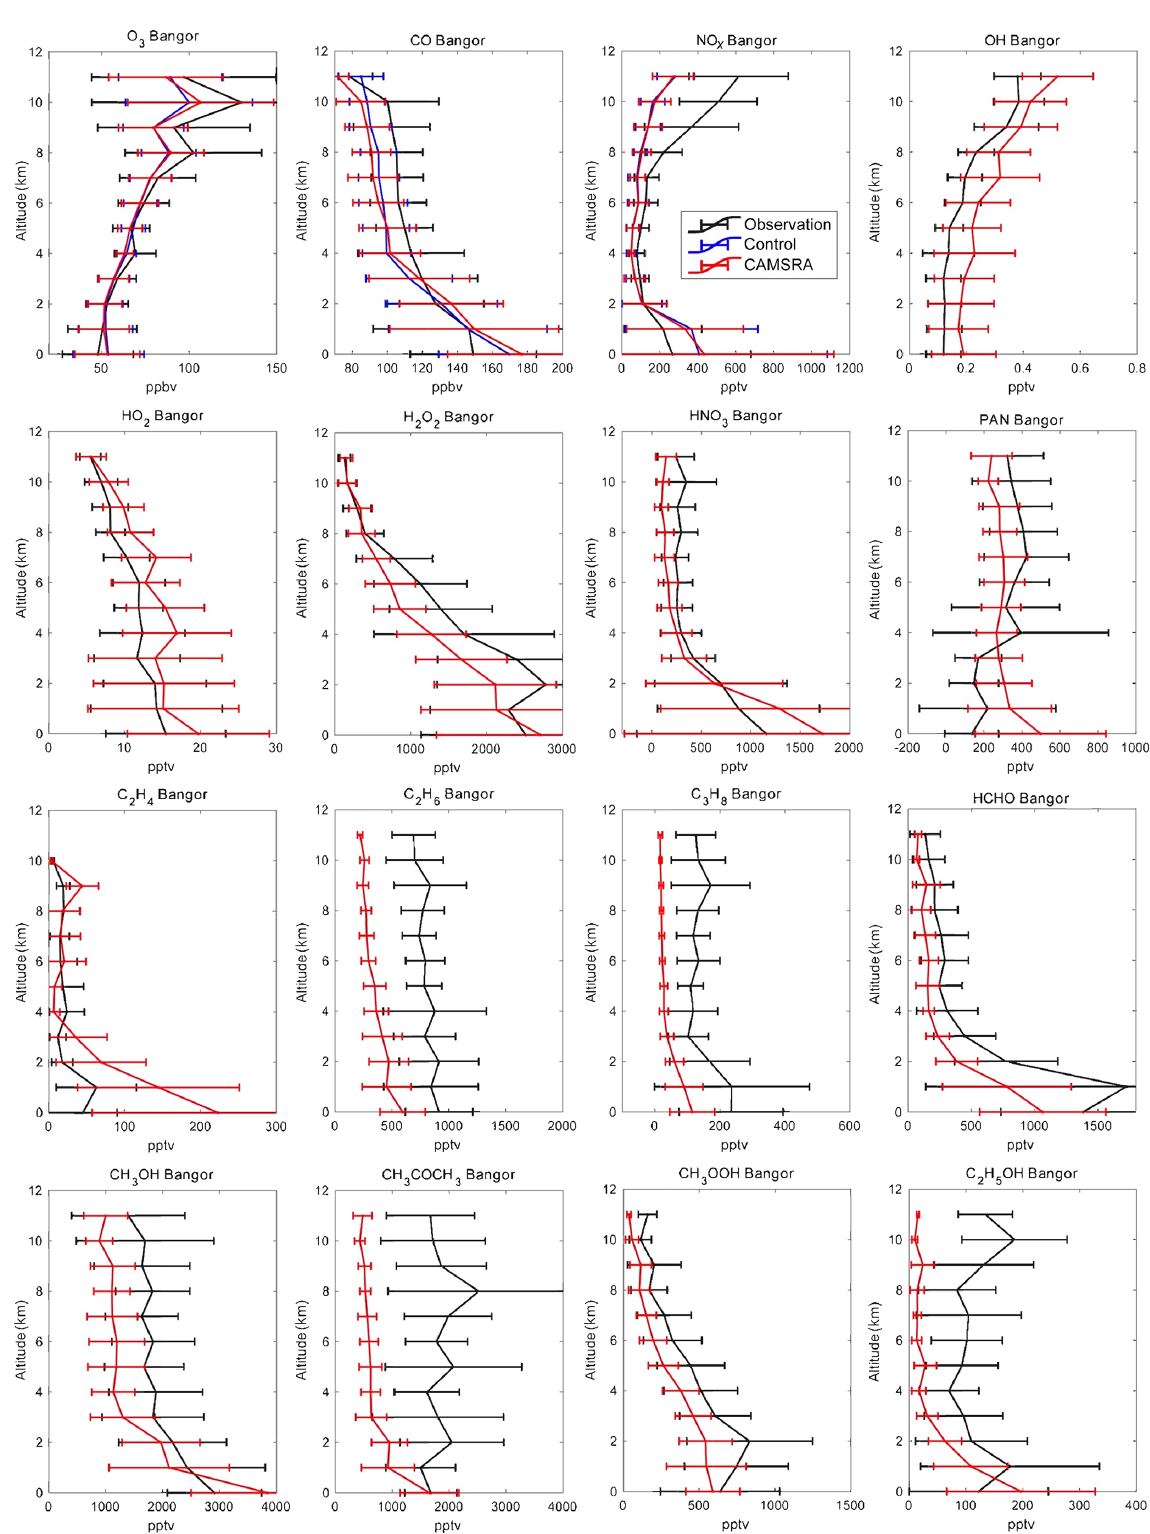
Figure 10. Averaged profiles of the trace constituents over Bangor during the INTEX-A campaign from July to August 2004. The black lines are the observations, the red lines correspond to the CAMSRA reanalysis, and the blue lines are the control run (only shown for O 3 , CO and NO x ). The error bars represent the standard deviation of the data and